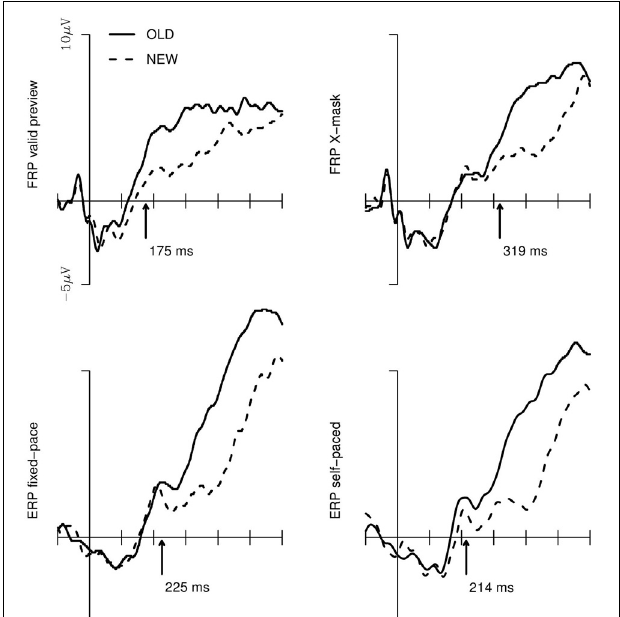
FIGURE 3 | Brain potentials in response to “old” vs. “new” words for the electrodes of the central cluster of the right hemisphere for the valid preview and the X-mask preview FRP conditions (upper row) and the fixed-pace and self-paced ERP conditions. The arrows indicate the point-in-time of the emergence of the old/new main effect which was assessed with the jackknife procedure (Ulrich and Miller, 2001; see